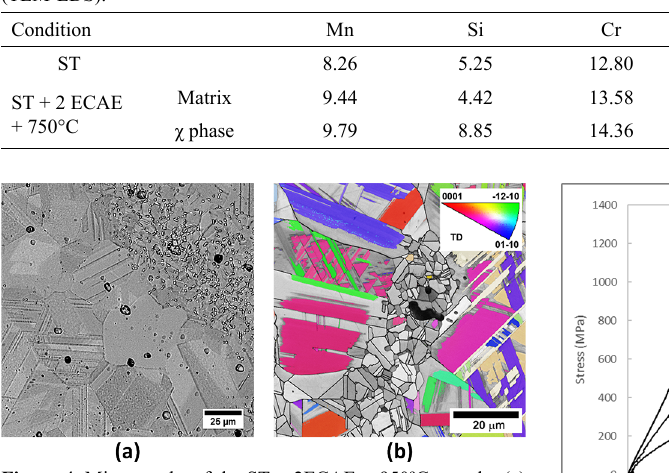
Figure 4. Micrographs of the ST + 2ECAE + 950ºC sample: (a) SEM-SE, (b) Pattern Quality Map overlaid with a Martensite IPF Map - EBSD (ND-TD).